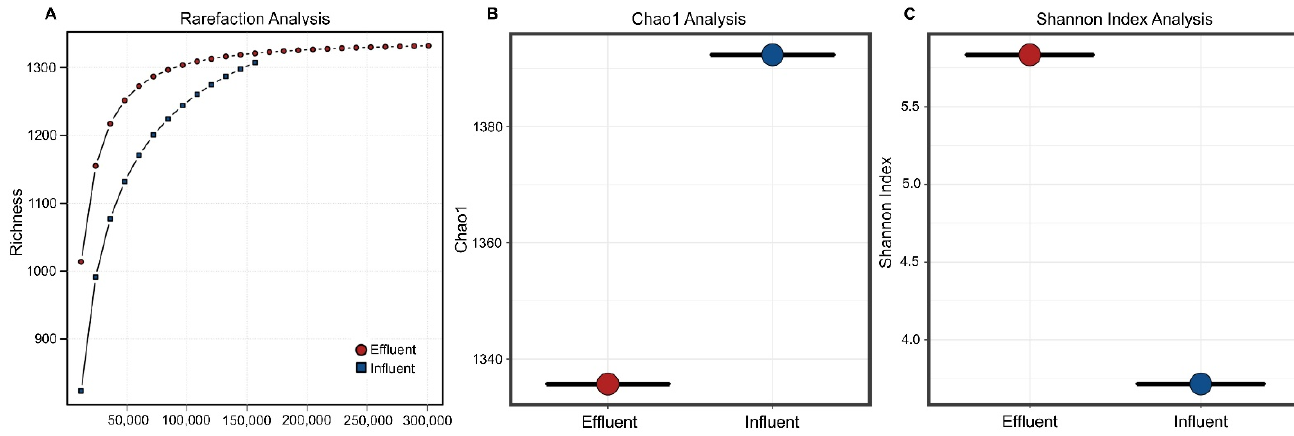
Figure 1. Diversity analysis of the domestic sewage metagenomes sequence reads. ( A ) Rarefaction analysis of influent and effluent samples, ( B ) chao1 index, and ( C ) Shannon diversity index.